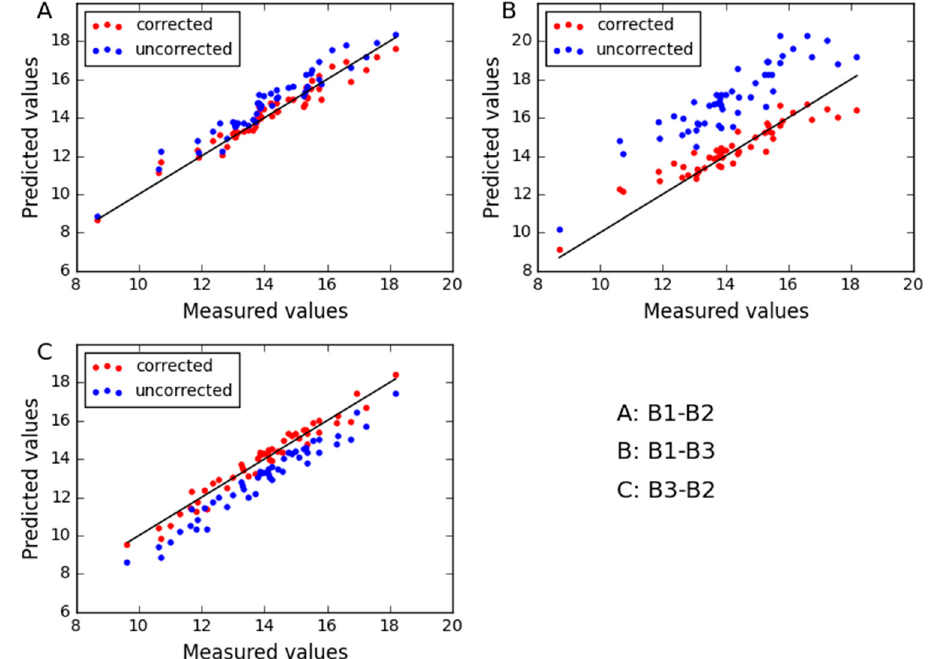
Figure 7. The relationship between the uncorrected and the corrected predict values for wheat dataset predicted by ( A ) B1-B2, ( B ) B1-B3 and ( C ) B3-B2. The blue and red dots represent the uncorrected and the corrected predicted results for each sample, respectively.